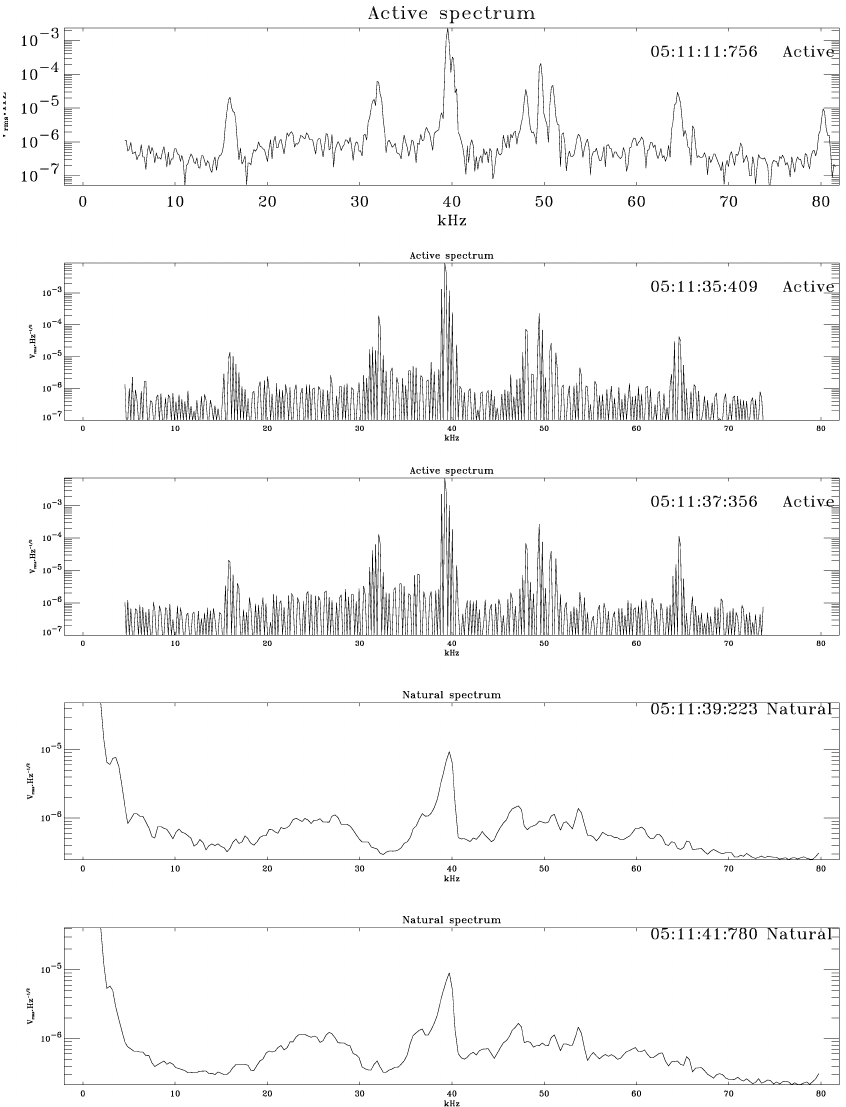
Fig. 6. Consecutive active and passive spectra collected on Tango at 05:11UT on 25 November. On the active spectra, the resonance at Fp is barely visible at 36.4kHz on the middle spectrum. Fuh and Fq are too close in frequency to be clearly